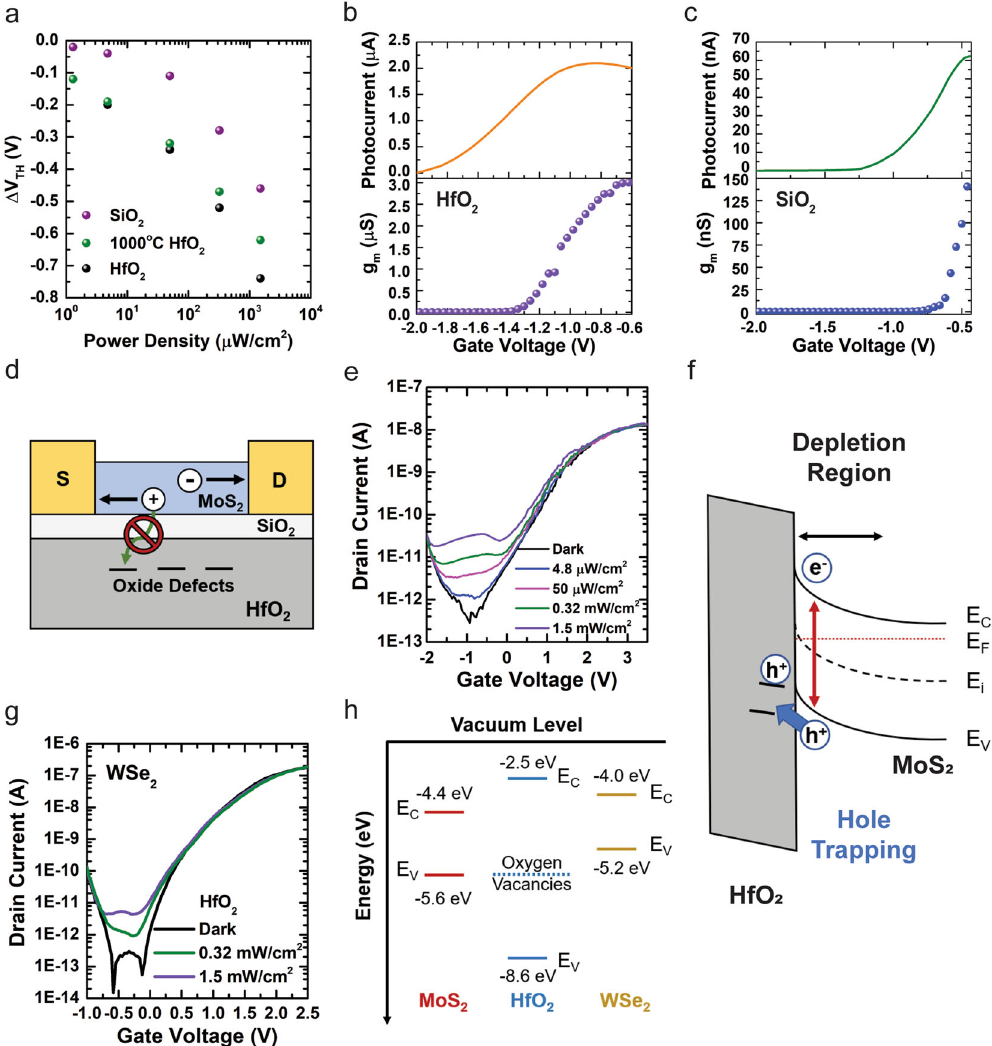
Fig. 4 Effects and mechanism of photogating with HfO 2 dielectrics. a Comparison of threshold voltage shift under illumination with no anneal HfO 2 , 1000 °C annealed HfO 2 , and SiO 2 phototransistors. b Photocurrent versus V G (top) and transconductance ( g m ) versus V G of HfO 2 device. c Photocurrent versus V G (top) and transconductance ( g m ) versus V G of SiO 2 device. d Device structure of SiO 2 interlayer as a charge-tunneling blocking layer with HfO 2 dielectric to suppress hole trapping. e Photoresponse of SiO 2 interlayer (3.4 nm)/HfO 2 (10 nm) MoS 2 phototransistor with V DS = 500 mV under the same blue light illumination with optical power densities at 4.8 μ W cm − 2 , 50 μ W cm − 2 , 0.32 mW cm − 2 , and 1.5 mWcm − 2 . f Model of charge-trapping mechanism from photogating effect. g Photoresponse of WSe 2 phototransistor (thickness ~5 nm) using HfO 2 dielectric (10 nm) with V DS = 250 mV under the same blue light illumination with optical power densities at 0.32 and 1.5 mWcm − 2 . h Band energy diagram of multi-layered MoS 2 , WSe 2 , and HfO 2 (based on ref. 44